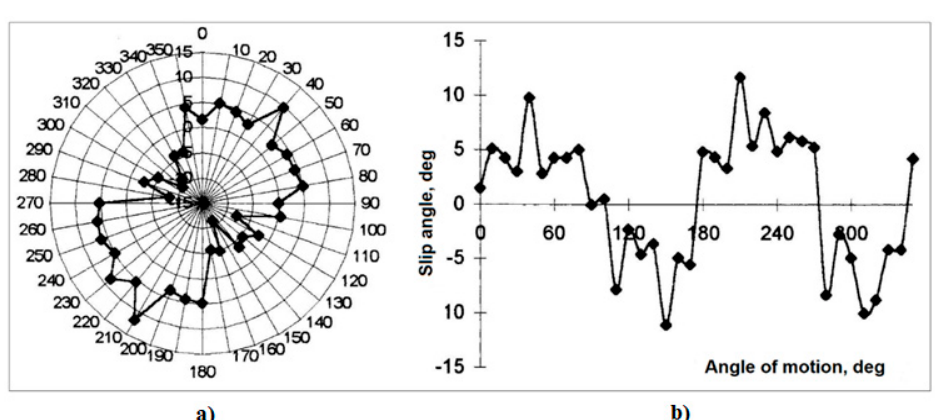
Figure 5. Change in the value of the slip angle from the angle of motion for full-scale samples in polar ( a ) and Cartesian ( b ) coordinates.